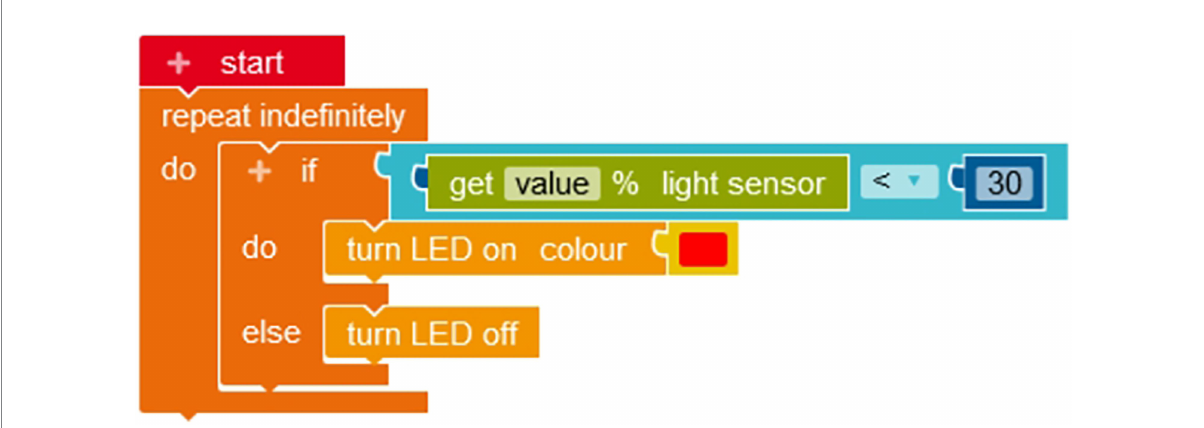
FIGURE 1 Example program for Calliope Mini ® using the NEPO ® programming language. Reproduced with permission from Open Roberta Lab, Fraunhofer- Institut für Intelligente Analyse-und Informationssysteme